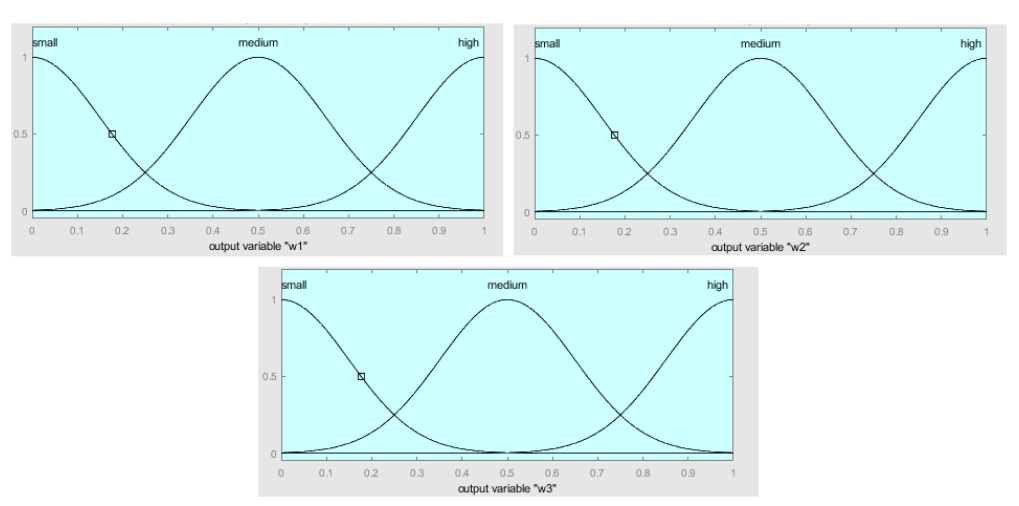
Figure 6. The fuzzy output membership function of 𝑤 1 , 𝑤 2 , and 𝑤 3 with Gaussian functions.